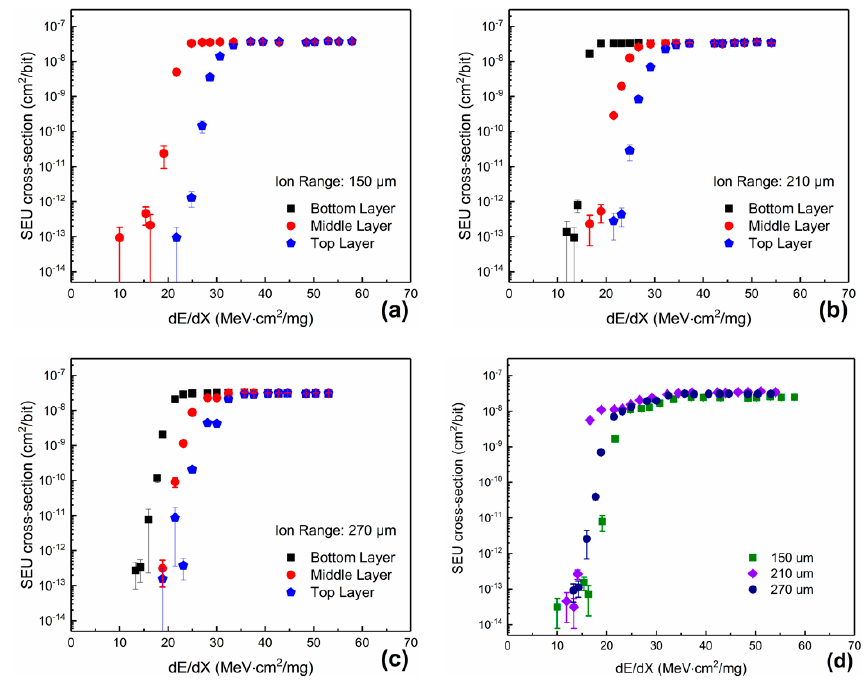
Figure 6. The CS of each tier as a function of LETs obtained using ( a ) 150- μ m, ( b ) 210- μ m, and ( c ) 270- μ m heavy ions; ( d ) the CS per bit as a function of LETs in different heavy-ion ranges. heavy ions; ( d ) the CS per bit as a function of LETs in di ff erent heavy-ion